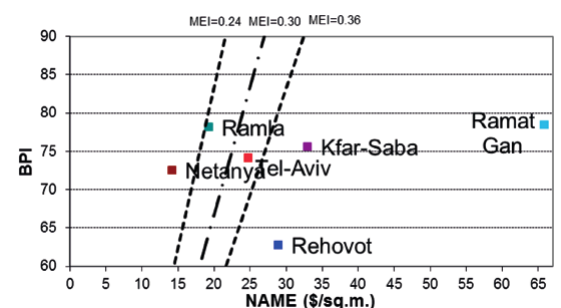
Figure 3. BPI Vs. NAME for the public facilities sample